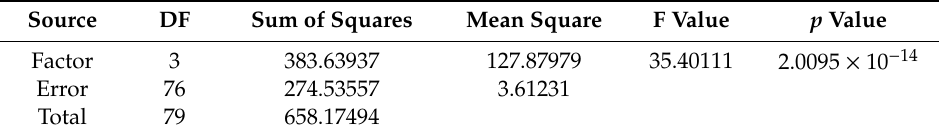
Table 3. Analysis of variance (ANOVA) for the average relative percent deviation (ARPD) of the compared algorithms in Table